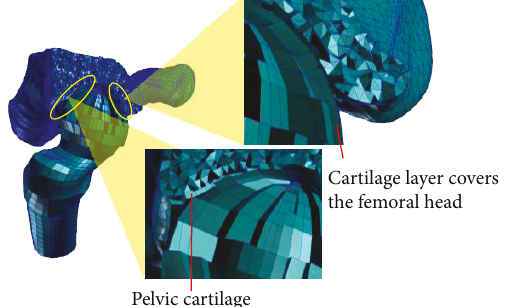
Figure 3: A cutaway view of the FE model illustrating interior mesh for the layers of articular cartilage covering the femoral head and acetabulum. Table 1: Material properties used in the hip FE models.